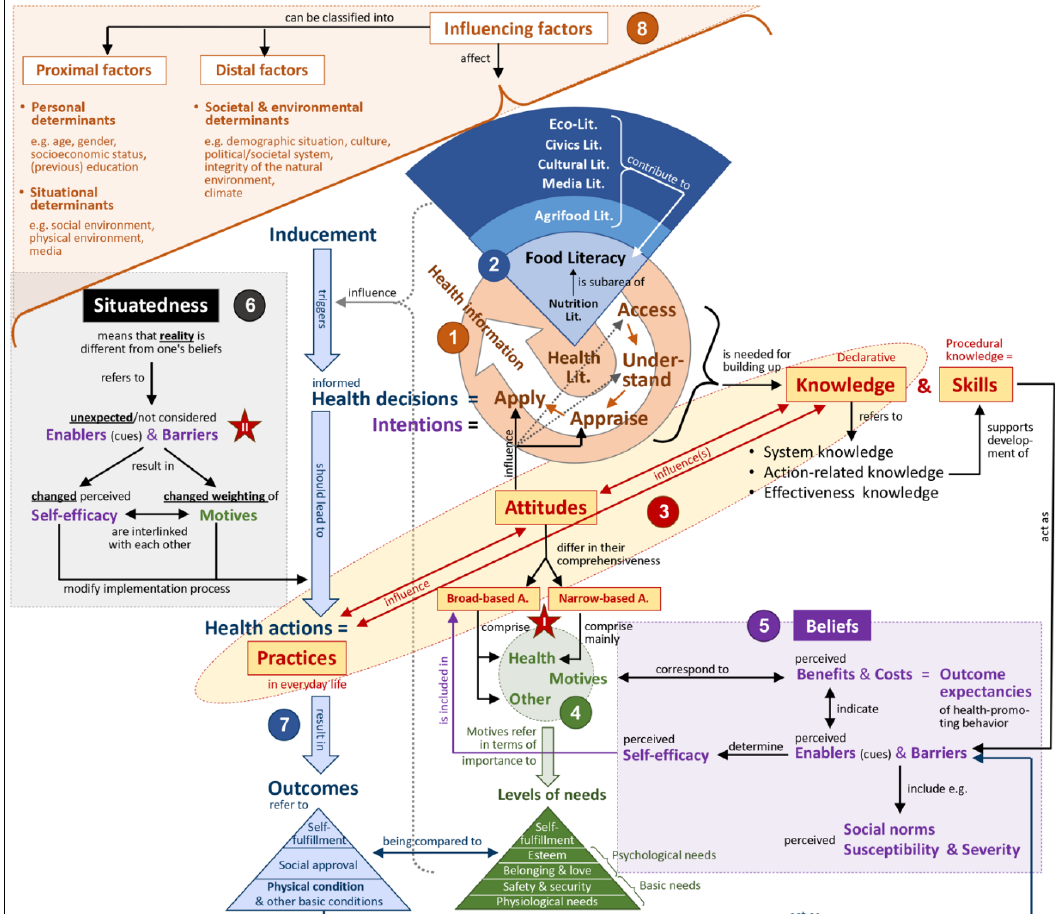
Figure 1. Conceptual Model Map of factors influencing Health and Nutrition Behavior (CMM HB/NB ). The circled numbers serve as reading hints and refer to the headings in the text. The two red stars refer to possible explanations for the attitude/intention–behavior gap (see Sections 2.4–2.6 in the text).